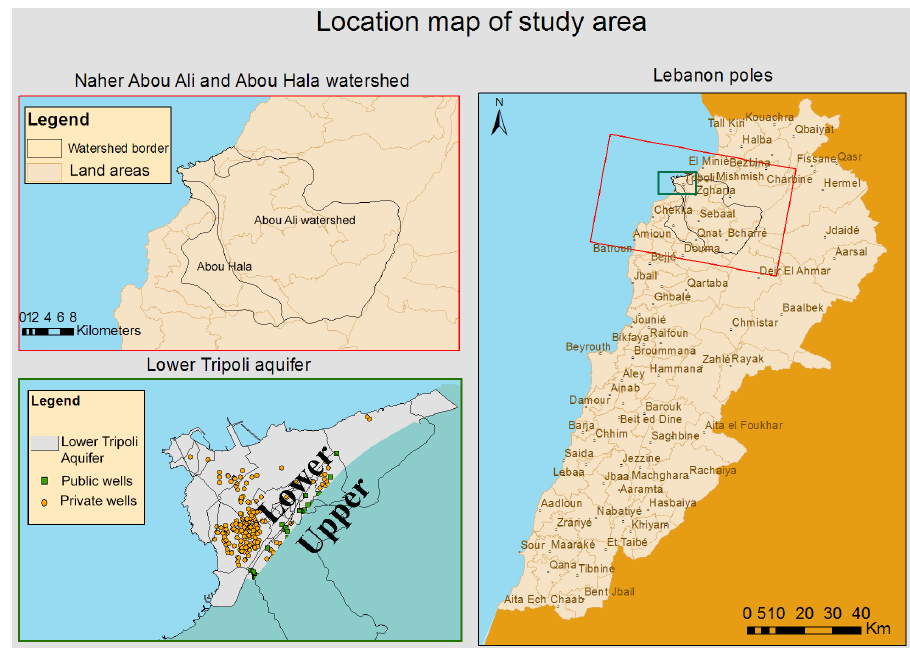
Figure 1. Location map of principal rivers watersheds in the city, study zone and wells positions, Lebanon